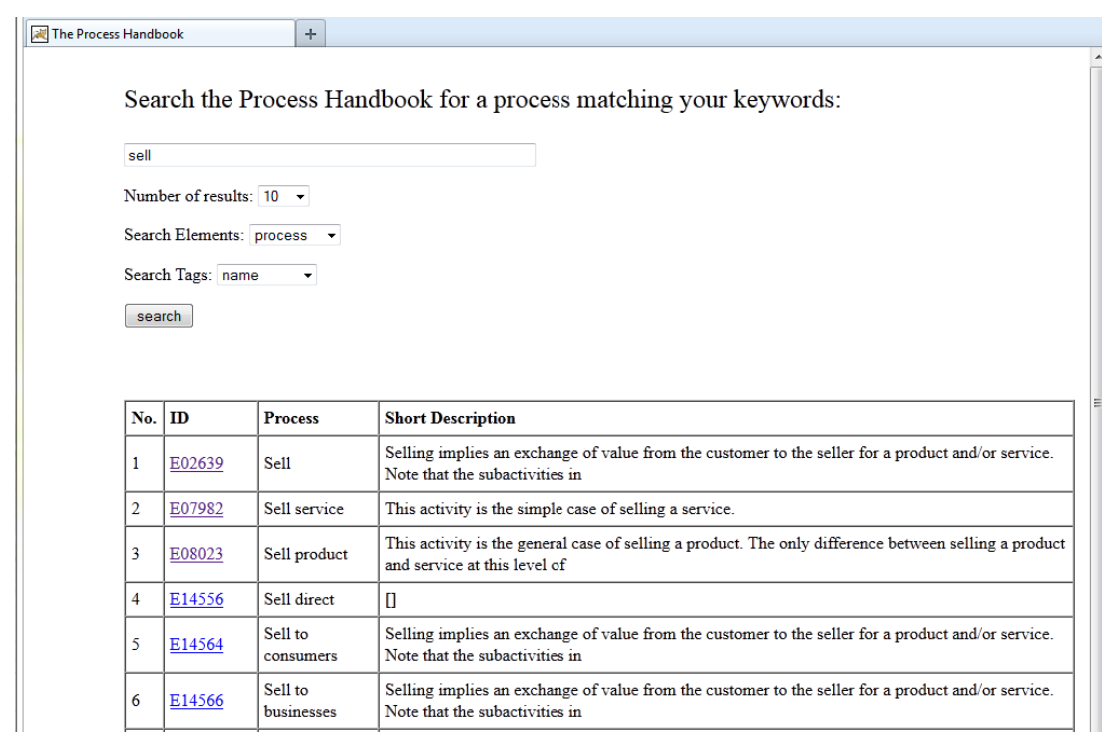
Figure 8. Browser-based interface for searching relevant